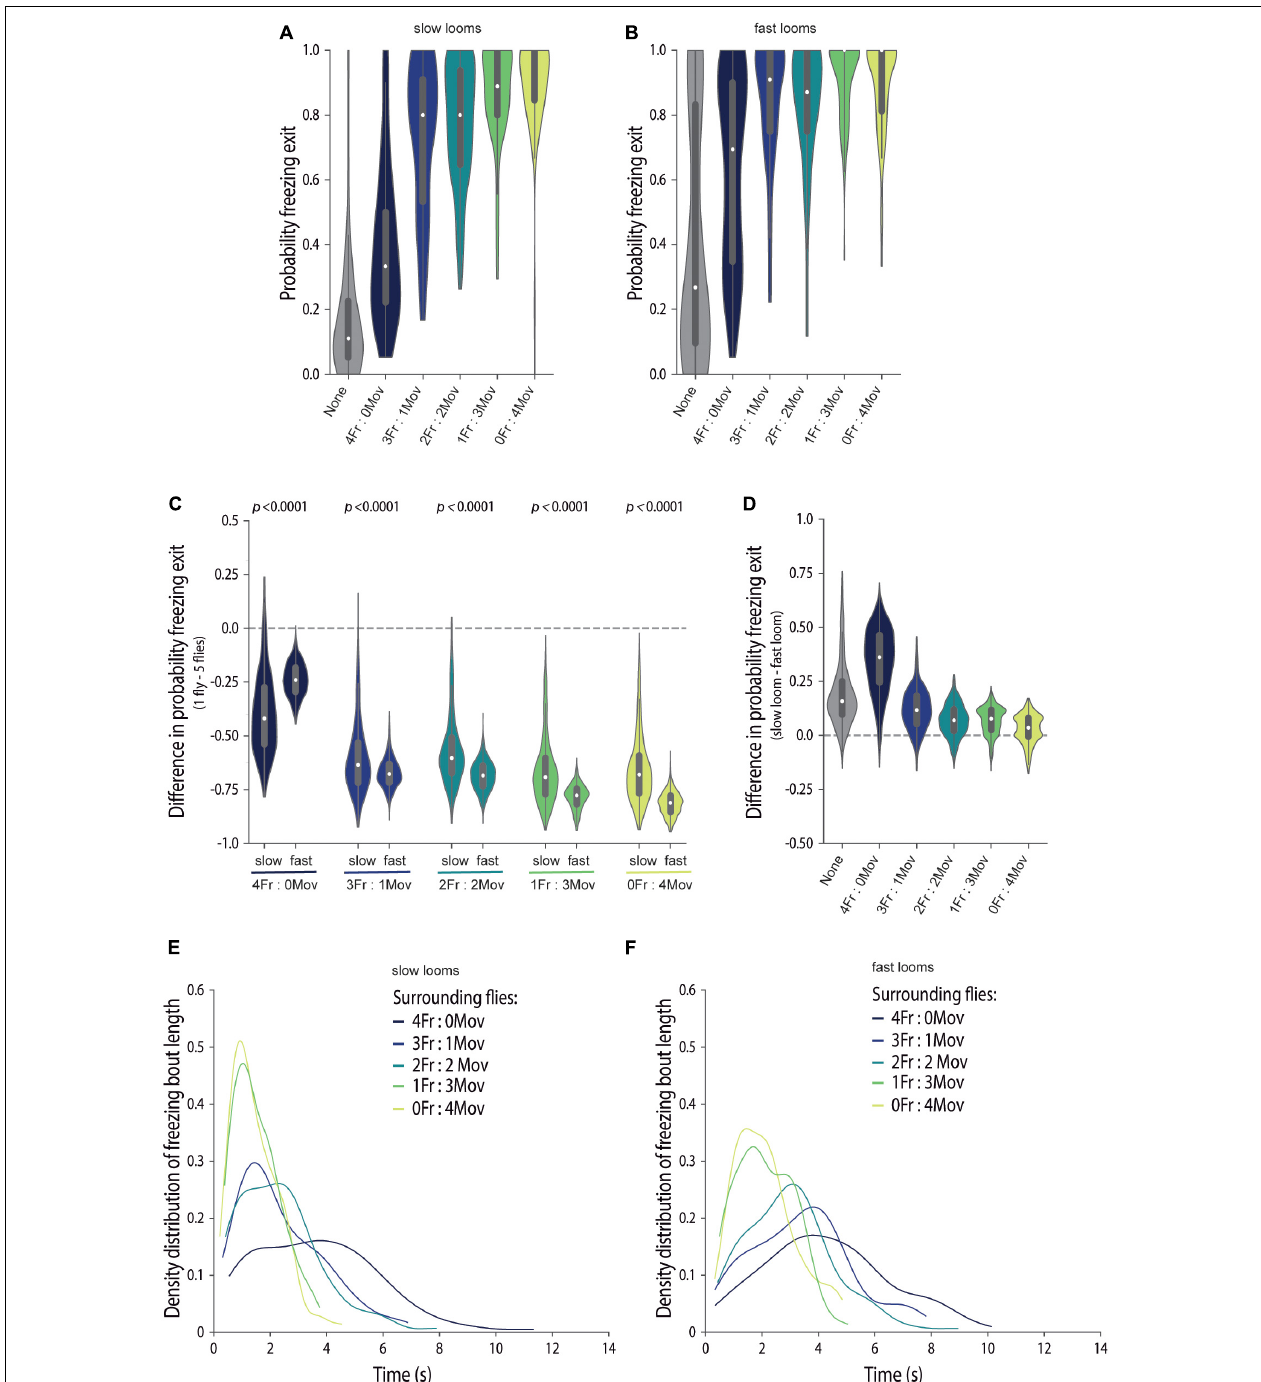
FIGURE 5 | Social cues of safety lead to freezing breaks, which underlie freezing response similarities across threat imminences. (A–F) We manipulated focal flies to surround with four flies creating groups with different proportions of flies that always move (blind flies, NorpA) and flies that are optogenetically made to freeze (LC6 > CsChrimson). The color code for the groups is presented in (E,F) ; gray shadings represent an individually tested wild-type fly. (A–D) Violin plots representing the probability density distribution of individual fly data bound to the range of possible values, with boxplots elements: central white dot, median; [box limits, upper (75) and lower (25) quartiles; whiskers, 1.5 × interquartile range]. Probability of freezing exit before the following looming stimulus when exposed to slow (A) or fast looming stimuli (B) . (C) Difference in the probability of freezing exit between individually tested flies and flies tested in groups for slow and fast looms (refer to the section “Materials and Methods”). P -values result from the two-tailed Mann–Whitney test. (D) Difference in the probability of freezing exit between focal flies exposed to the two looming speeds, for each group composition (refer to the section “Materials and Methods”). Statistical comparisons between conditions are presented in Supplementary Table 2 . Kernel density estimate plots of the distribution of freezing bout lengths for flies exposed to slow (E) and fast (F) looms.